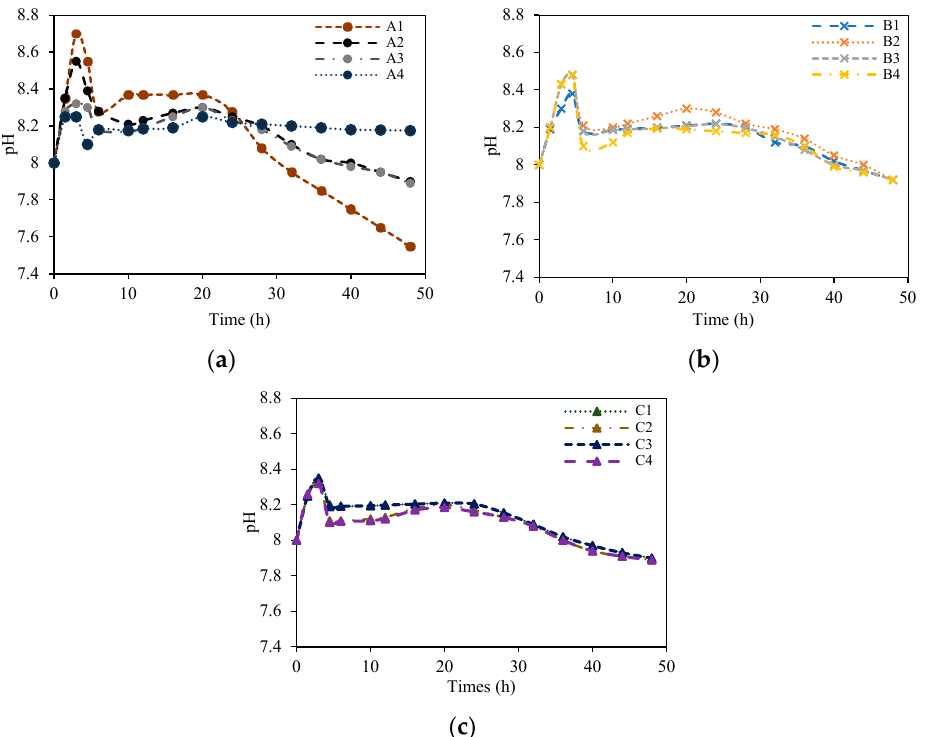
Figure 3. Trend of pH during fermentation time for different nutrients: ( a ) phosphate, ( b ) ferrous ion, and ( c ) sulfate.